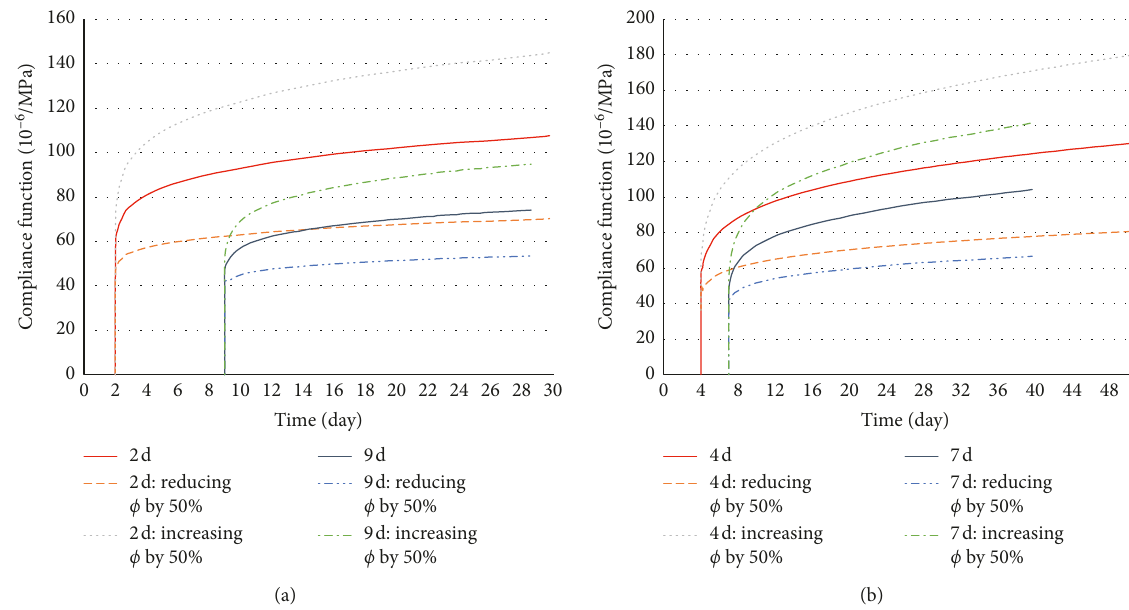
Figure 17: Compliance function with parameter φ reducing and increasing by 50%.